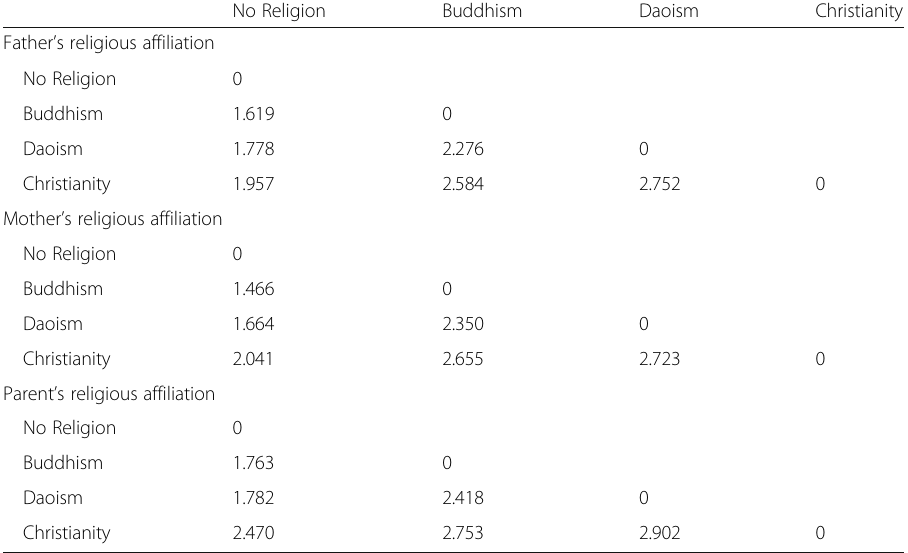
Table 4 Religious distance matrix